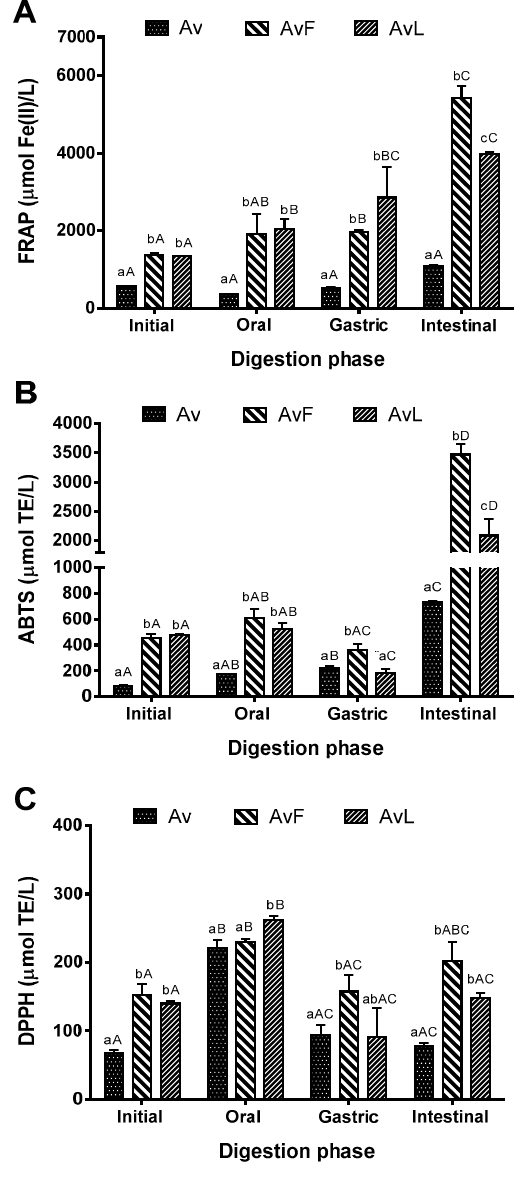
Figure 4. Antioxidant activity of non-digested and digested Aloe vera juices by ( A ) FRAP assay, ( B ) ABTS assay, and ( C ) DPPH assay. Av : Digestion of non-fermented Aloe vera extract; AvF : Digestion of Aloe vera extract fermented with Enterococcus faecium ; AvL : Digestion of Aloe vera extract fermented with Lactococcus lactis . Data bearing different lowercase letters (a–c) in the same digestion phase are significantly different ( p < 0.05). Data bearing different capital letters (A–D) in the same sample groups are significantly different ( p < 0.05).